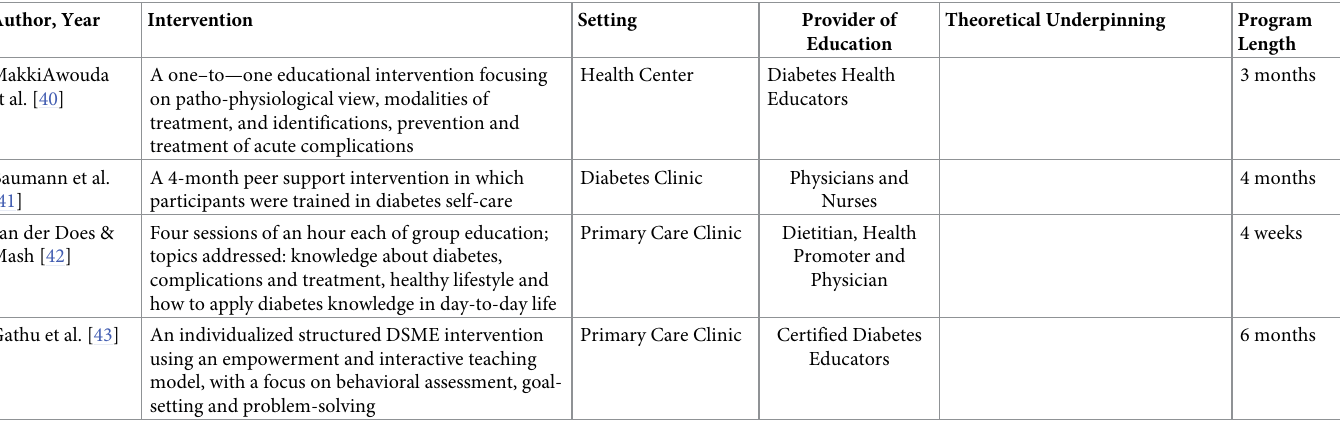
Learning outcomes. Two indicators of learning outcome were assessed: self-efficacy (con- fidence in self-management) and diabetes knowledge. Self-efficacy was assessed in four studies.